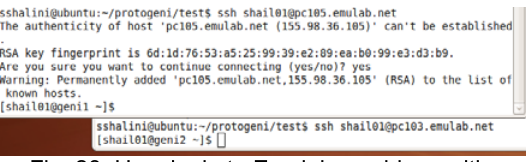
Fig. 2 8: User login to Emulab machines with changed SSH